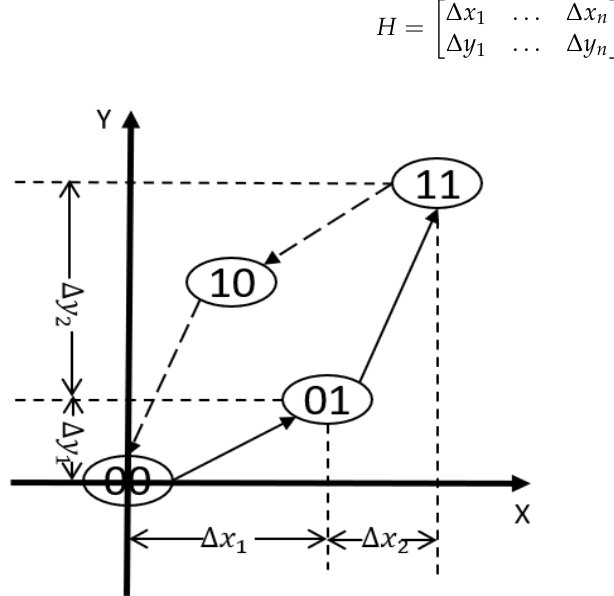
Figure 3. The paired properties of the digitized representation with two